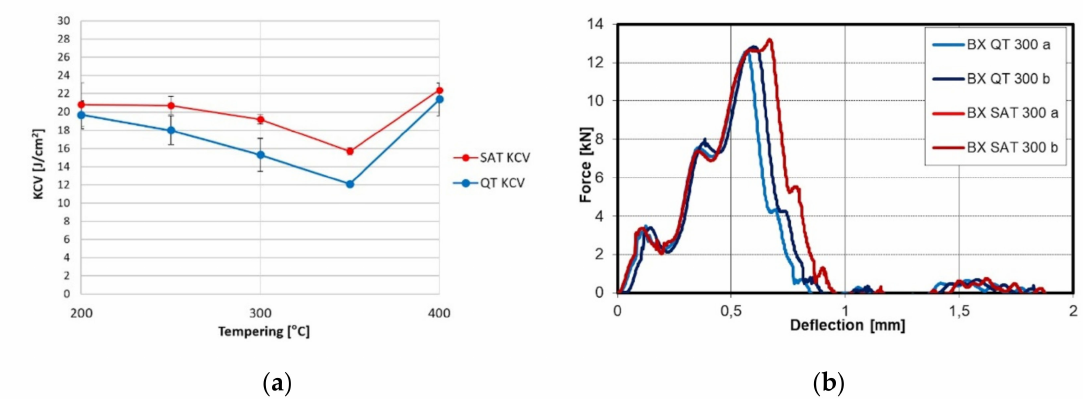
Figure 4. ( a ) KCV trend after conventional QT and SAT processing; ( b ) instrumental Charpy graph after conventional QT and SAT processing at 300 ◦